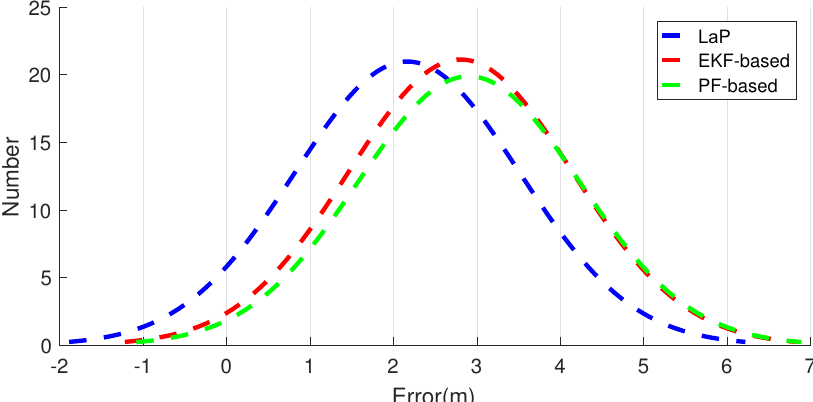
Figure 16. Localization error distribution of LaP and two other approaches.